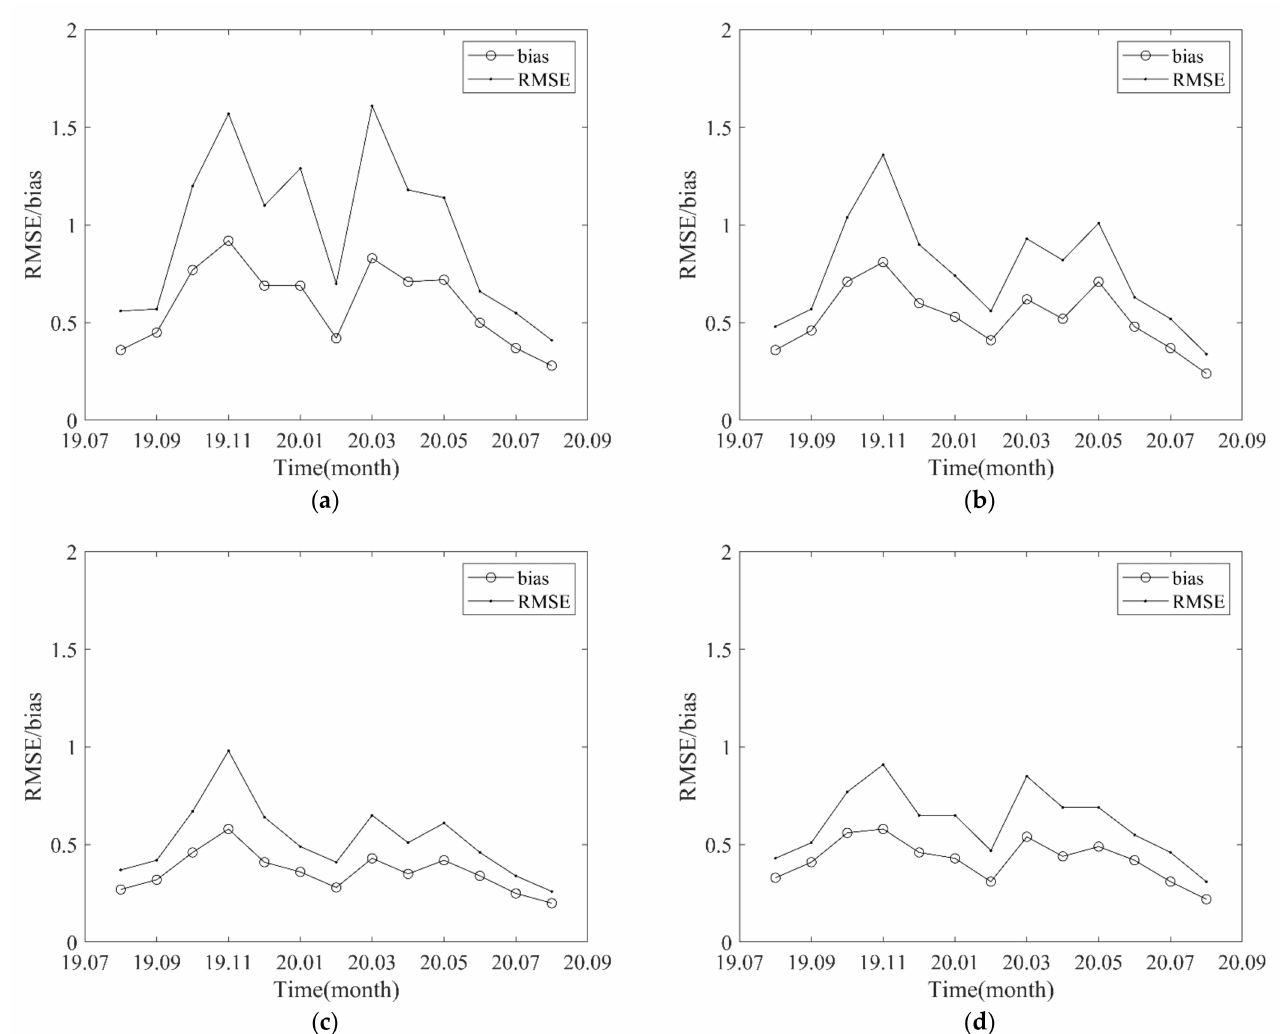
Figure 11. Monthly biases and RMSEs of off-nadir SWIM SWH data compared to Jason-3 data: ( a ) 6 ◦ beam, ( b ) 8 ◦ beam, ( c ) 10 ◦ beam and ( d ) combination of three beams.